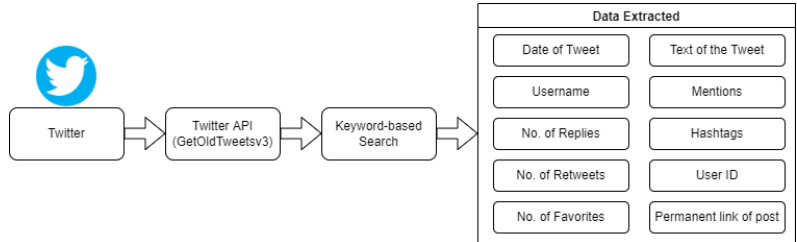
Figure 3. Process of data collection from